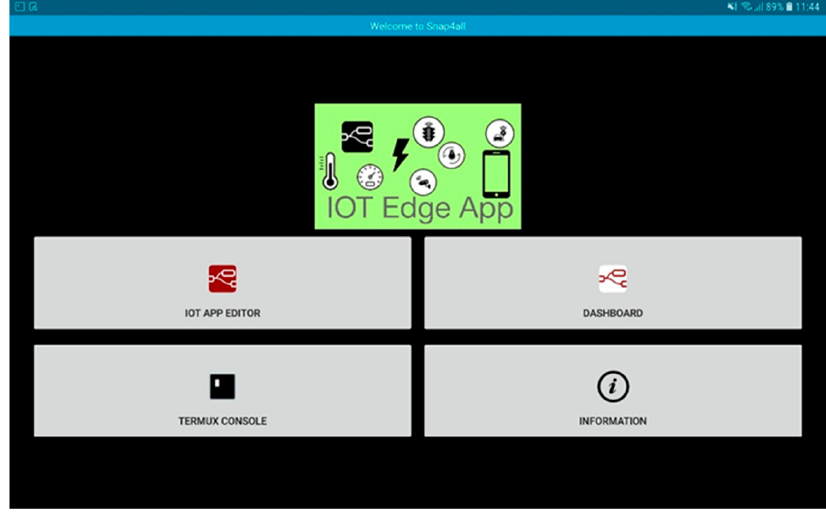
Figure 3. Screenshot of the application that allows to turn an Android tablet into an IoT Device.